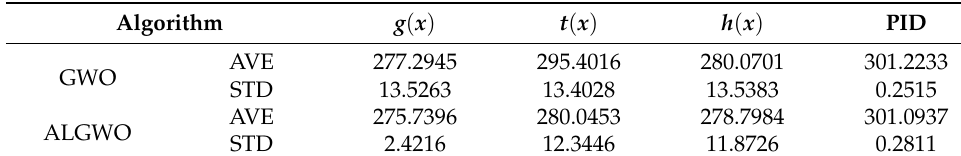
Table 6. The comparison of final fitness of algorithms on test system 3.